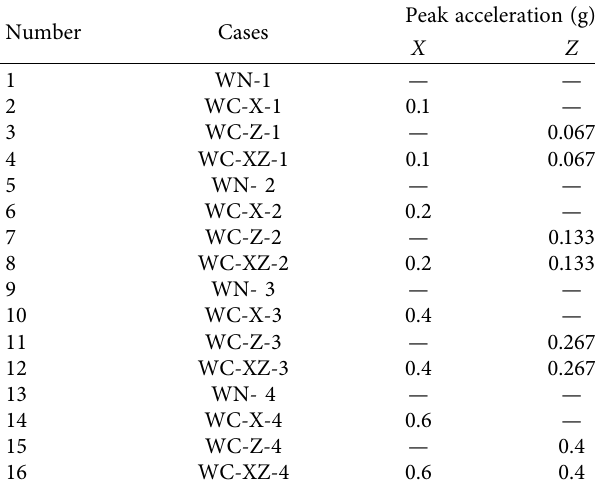
Table 4: Loading rule of the shaking table